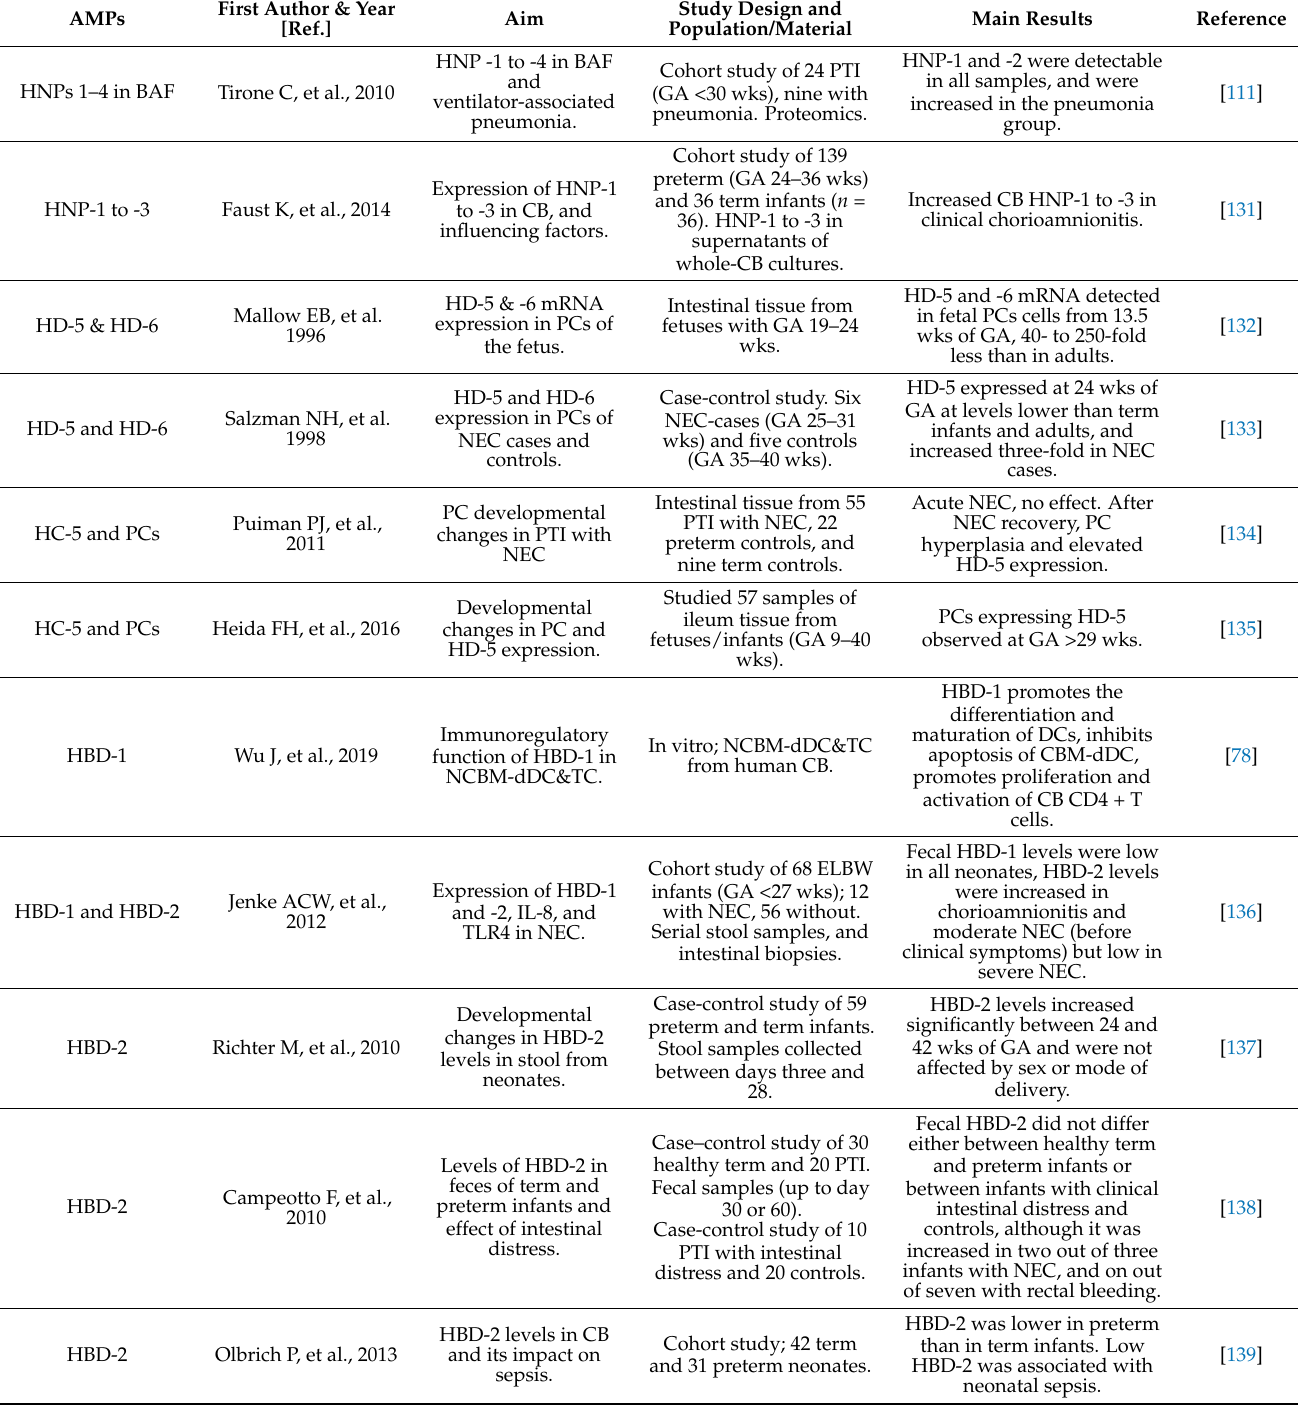
Table 3. Studies regarding AMP expression and levels in human fetuses and neonates in health, sepsis, and